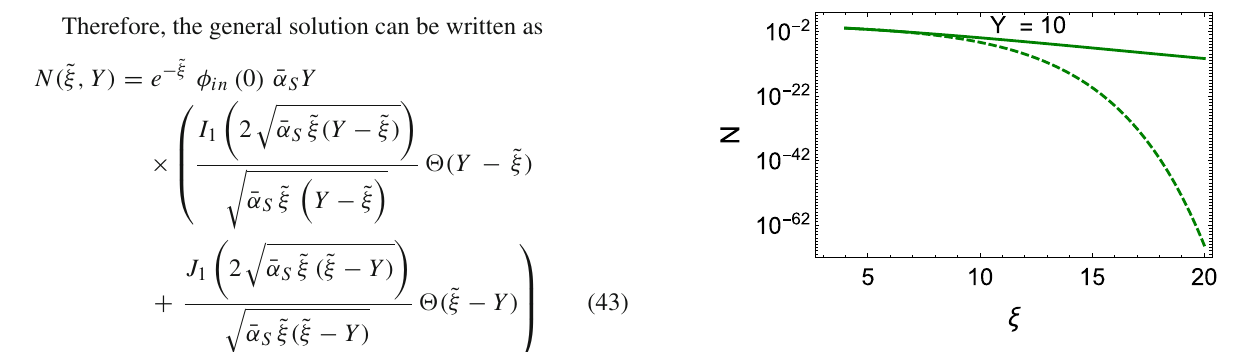
Fig. 3 Numerical estimates for N , which comes from Eq. (44) fixing B 1 = 1 and B 2 = 1 in Eq. (13), ¯ α S = 0 . 2 and Y = 10 (solid line). The (cid:23) (cid:21) 2 − 1 . 06 e 1 4 ξ dotted line is N ∝ exp Table 1 Numerical value for the slope μ in GeV versus Y = ln ( 1 / x )